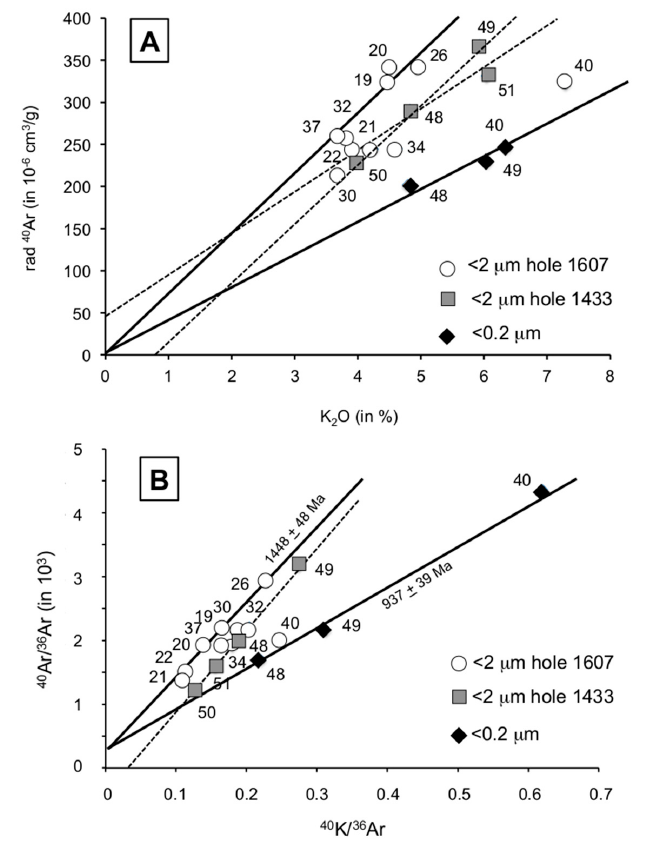
Figure 2. ( A ) Harper [23] pattern and ( B ) isochron diagram of the previously studied <2 and the herein analyzed <0.2 μ m illite-rich size fractions. analyzed < 0.2 µ m illite-rich size